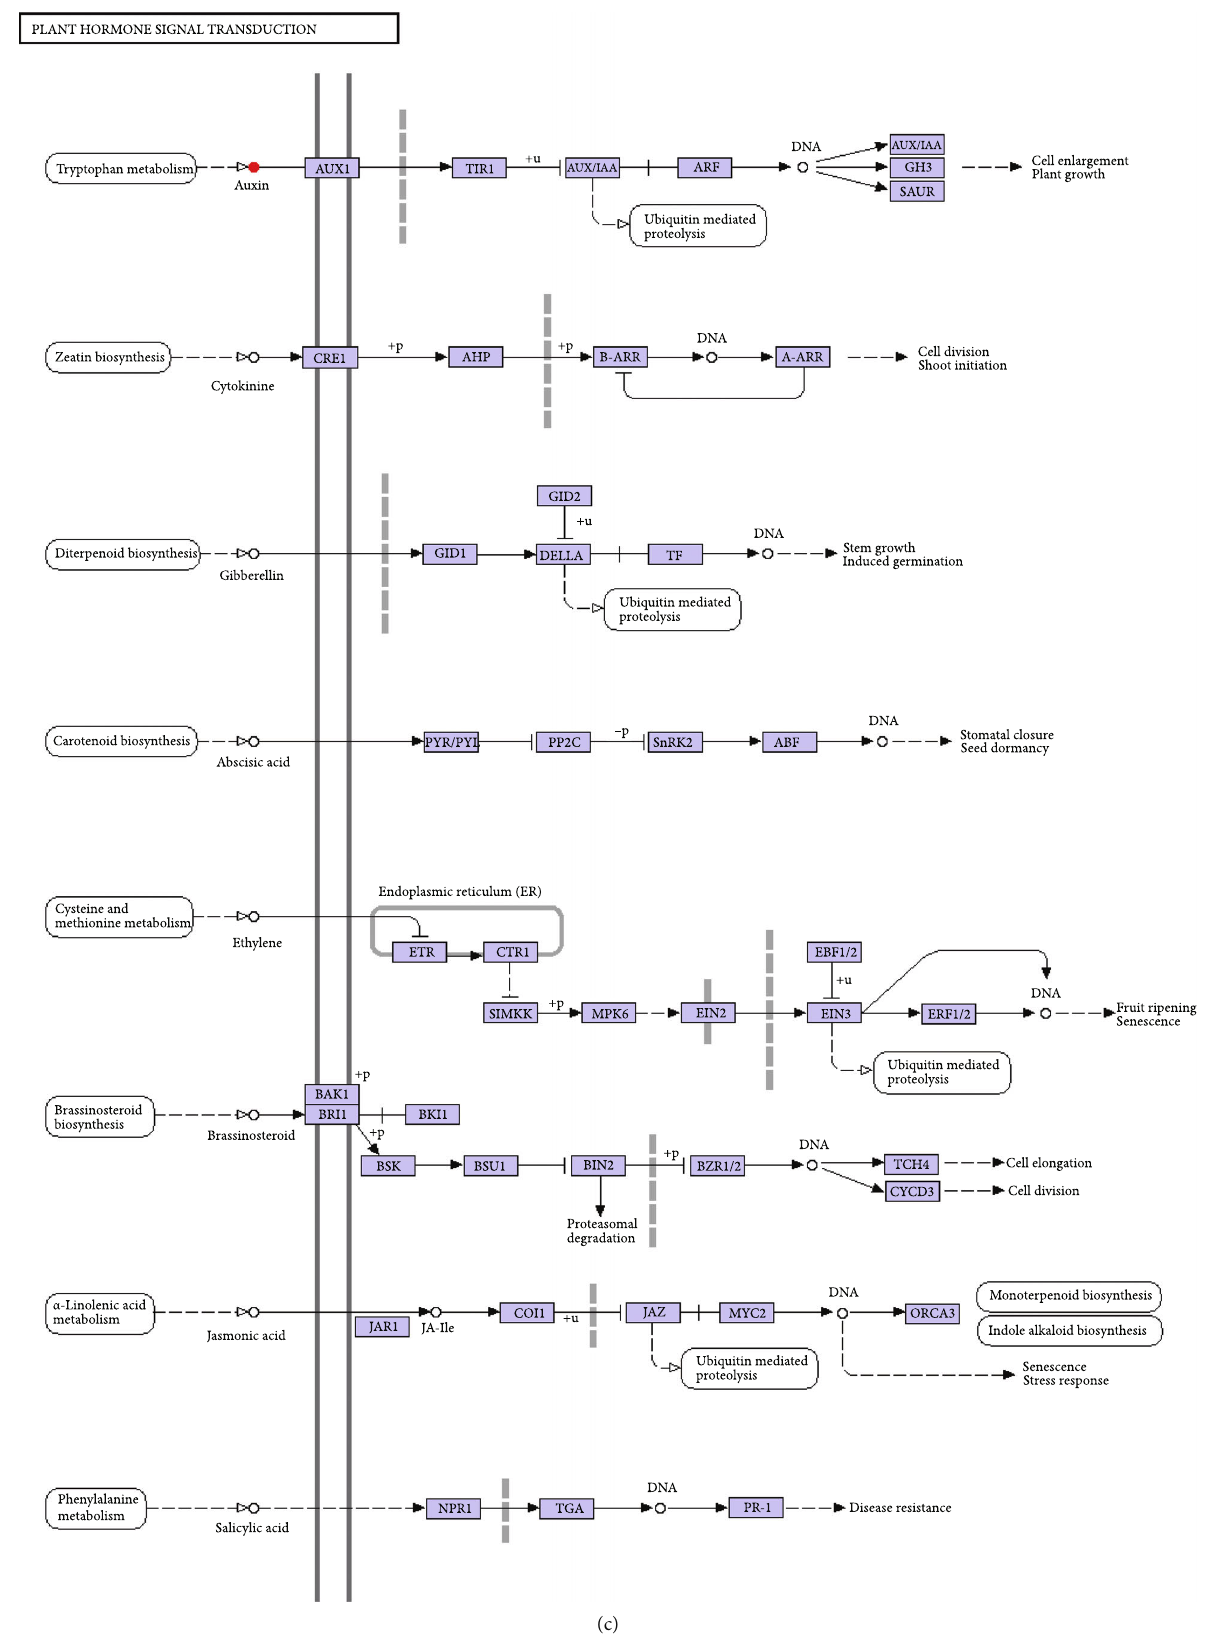
Figure 4: Metabolic pathways of Bacillus megaterium . (a) Amino acid biosynthesis. (b) Diterpenoid biosynthesis. (c) Plant hormone signal